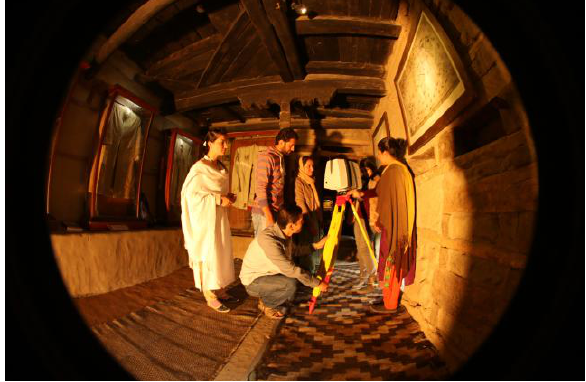
Figure 11. Demonstration of 3D laser scanning to members of the Ciqam team in Baltit Fort